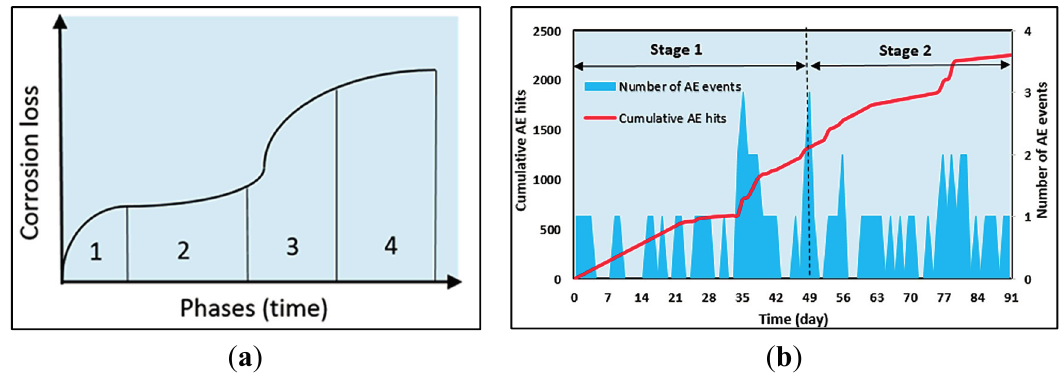
Figure 5. ( a ) Typical corrosion loss of steel reinforcement due to chloride immersion (Reproduced and modified from ([160]); and ( b ) cumulative AE hits and number of AE events during corrosion test (Reproduced and modified from